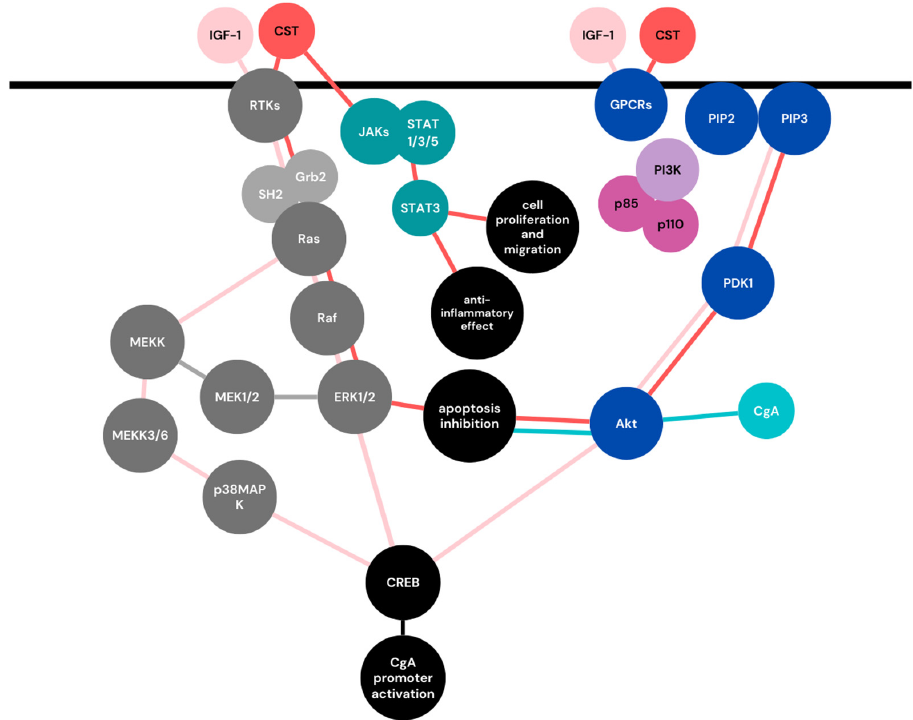
Figure 3. Pregnancy-related signaling pathways of chromogranin A and catestatin. Schematic representation of the signaling pathways activated duringpregnancy. MEKK: MAPK/ERK kinase. Light pink color marks pathways activated with IGF-1, resulting in CgA promoter activation. Orange color marks signaling pathways activated by CgA-derived peptide, CST. Additional relationship between CgA and Akt, through up-regulation of survivin protein, was marked with sea color. Gray color represents MAPKs signaling pathway, blue PI3K/Akt signaling pathway; black is reserved for each pathway’s end-effect related to CgA.